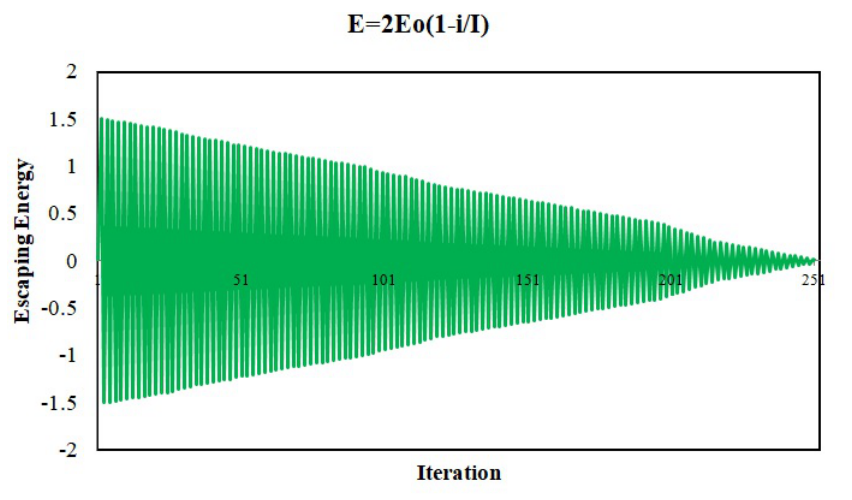
Figure 4. For 250 iteration, E’s behavior changes with